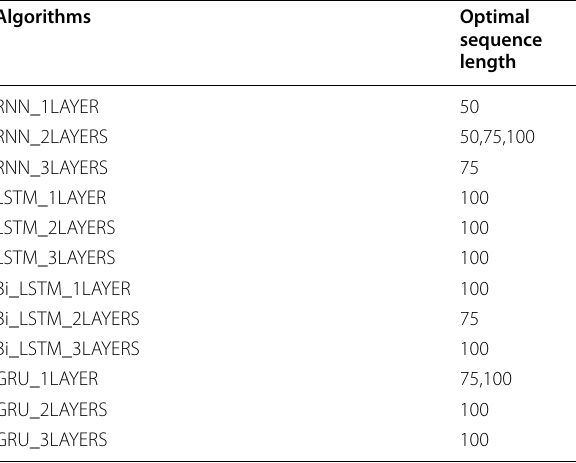
Table 5 Optimal sequence length for different algorithms Algorithms